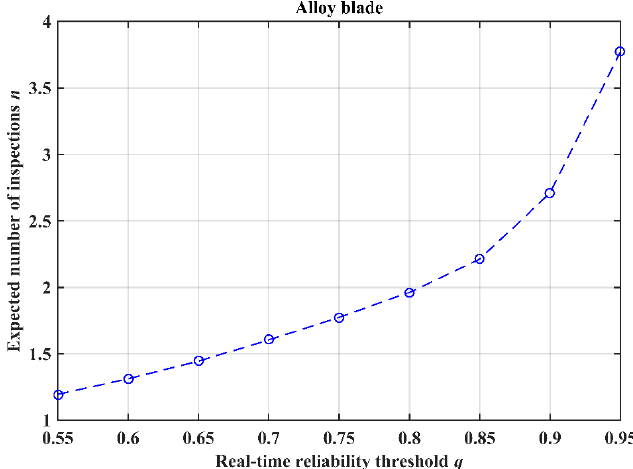
Figure 12. Total expected number of inspections versus the real-time reliability threshold q at w 0 = 1.58 inches (1 inch = 2.54 cm). Processes 2019 , 7 , 481